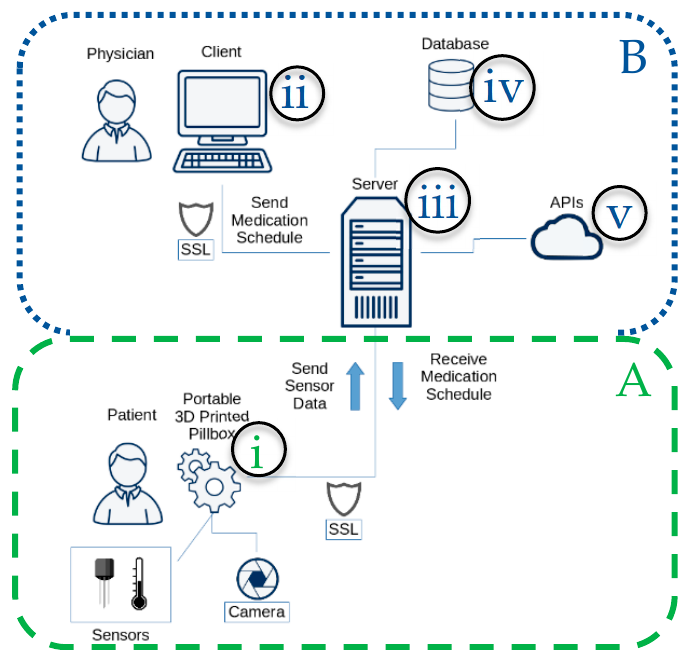
Figure 1. IoMT platform overview: Space A supports the interaction with the patient through the pillbox functionalities, while Space B includes the platform’s backend (server, database, cloud services) and frontend supporting a physician’s interaction through the web